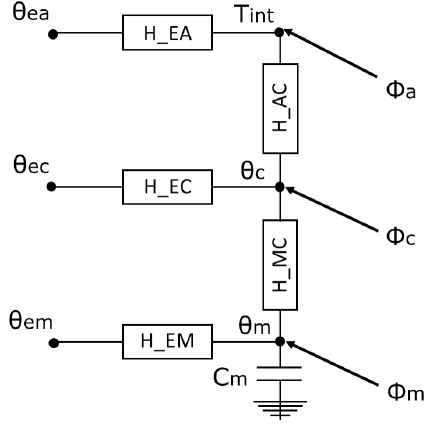
Figure 5. RC model according to SIA